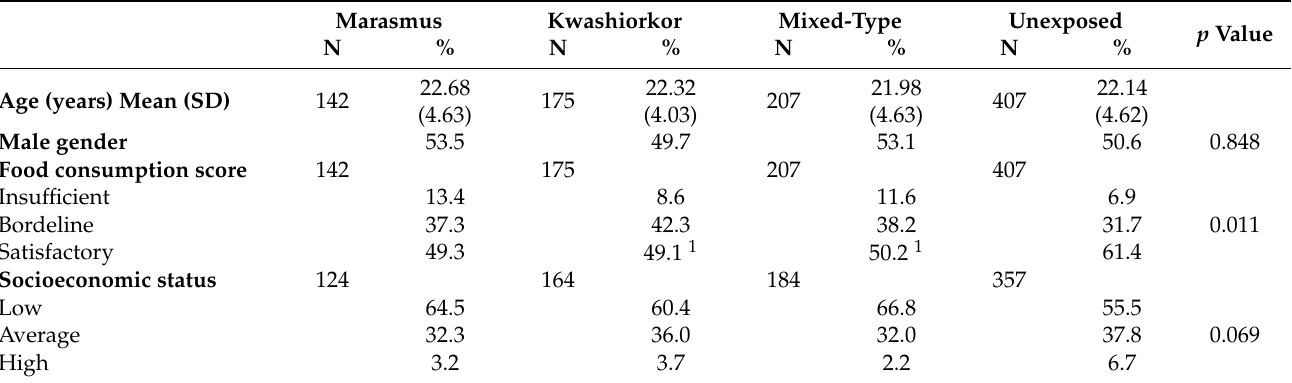
Table 1. Sociodemographic and economic characteristics of the three SAM subgroups and unex- posed controls.